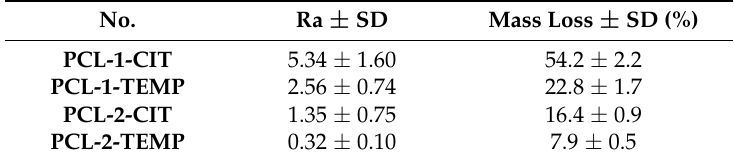
Table 5. Parameters of surface roughness and mass loss after 28 days in PBS solution at 37 ◦ C and pH 7.4.